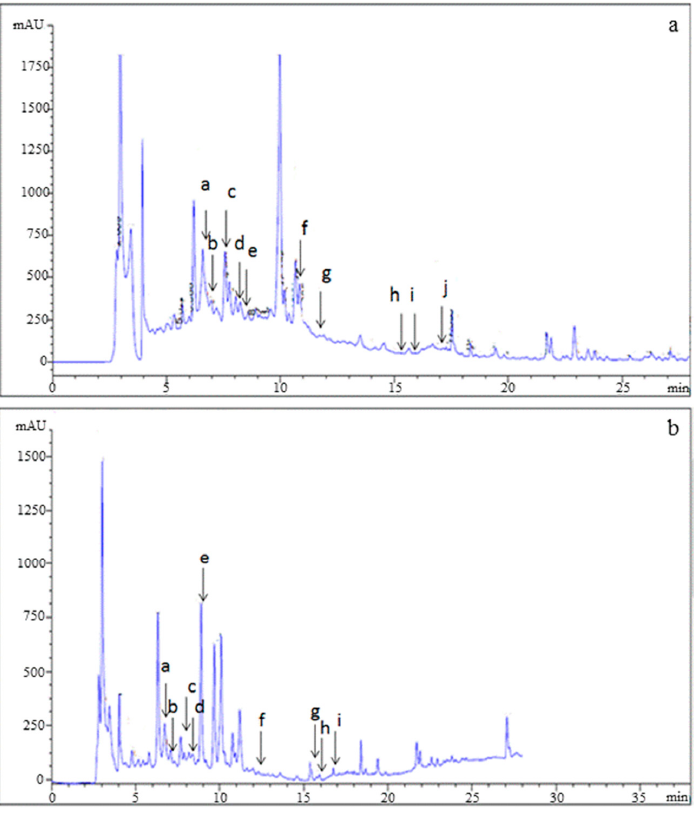
Figure 2. HPLC analysis of ( a ) standards and ( b ) juice extract of O. stricta cladode. Table 2. Chemical composition of ethanol extracts from O. stricta cladode juice by HPLC analysis.